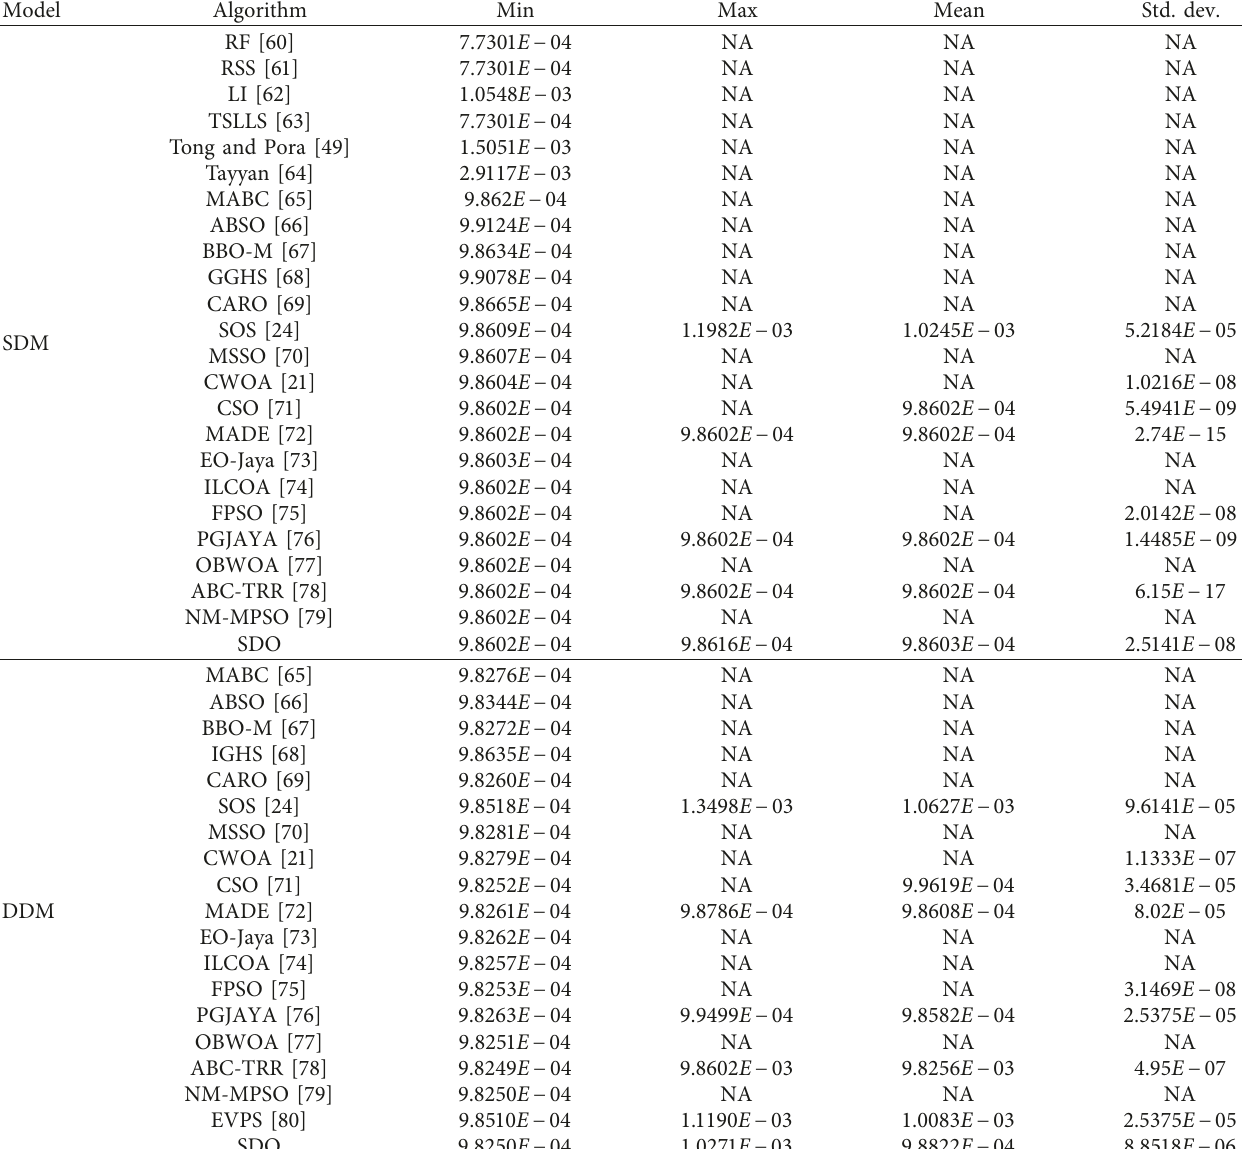
Table 15: Comparison with reported results on the RTC France solar